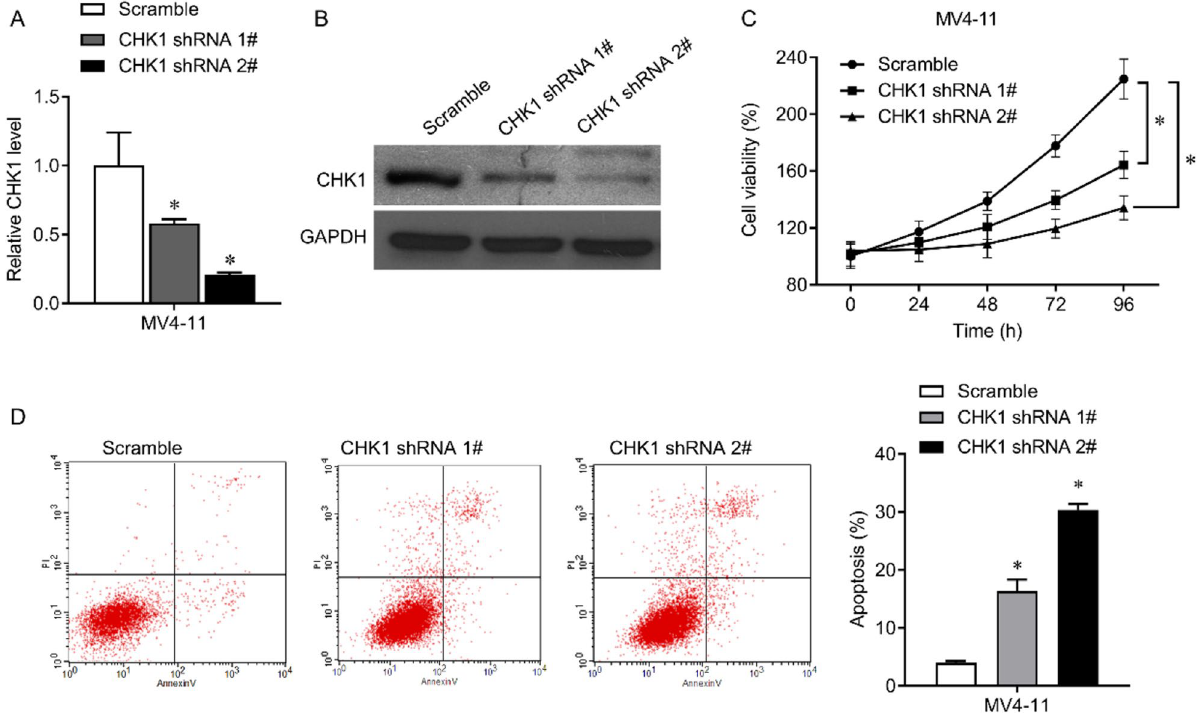
Figure 4. The effect of shRNA-mediated CHK1 knockdown on FLT3-ITD-positive AML cells. ( A , B ) 48 h after infection of MV4-11 cells with shRNA lentivirus, qRT-PCR ( A ) and Western blot ( B ) were used to detect the expression of CHK1. The original blots were presented in Supplementary Fig. 2. ( C ) CCK8 assay measured the cell viability of MV4-11 cells after treatment. ( D ) The effect of CHK1 knockdown on cell apoptosis in MV4-11 cells. The expressed values are shown as mean ± SEM. *p < 0.05.